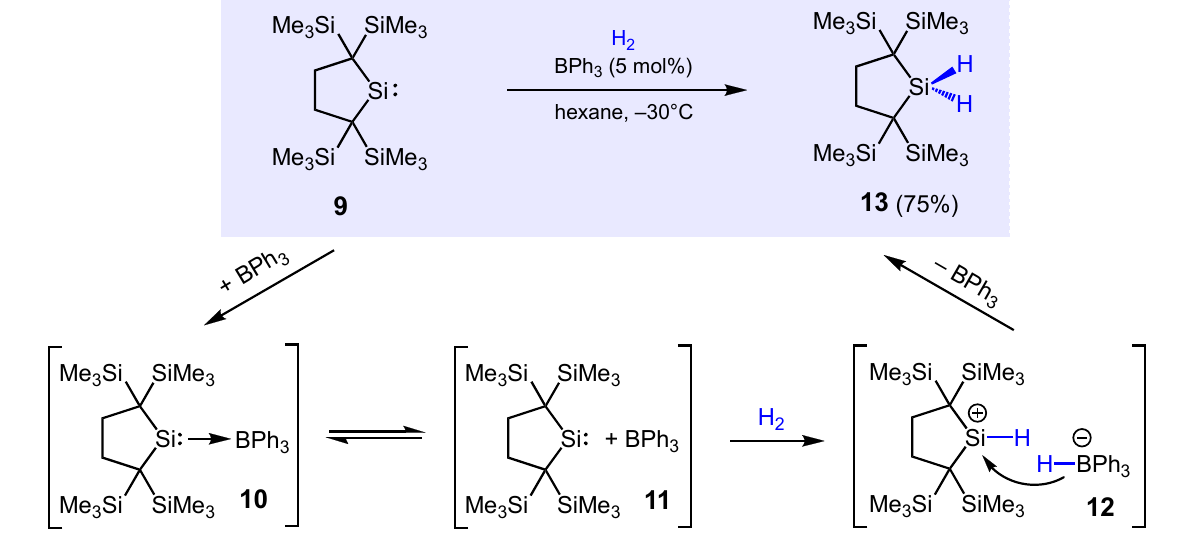
Scheme 10. BPh 3 -catalyzed hydrogenation of a silylene and proposed mechanism of formation.